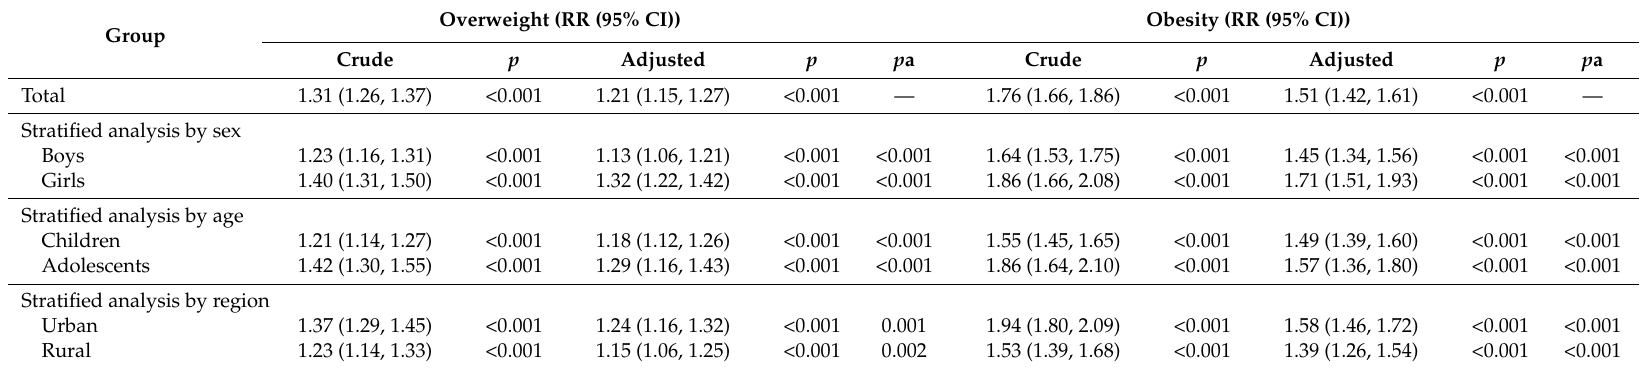
p Values refer to Wald’s test. p a: p value for interaction between stratified variables and delivery mode. Analyses were adjusted for birth weight, gestational age, maternal age at childbirth, maternal education level, paternal education level, region, sex, and year of birth. The sex-subgroup analysis was adjusted for all covariates except for sex; the area-subgroup analysis was adjusted for all covariates except for